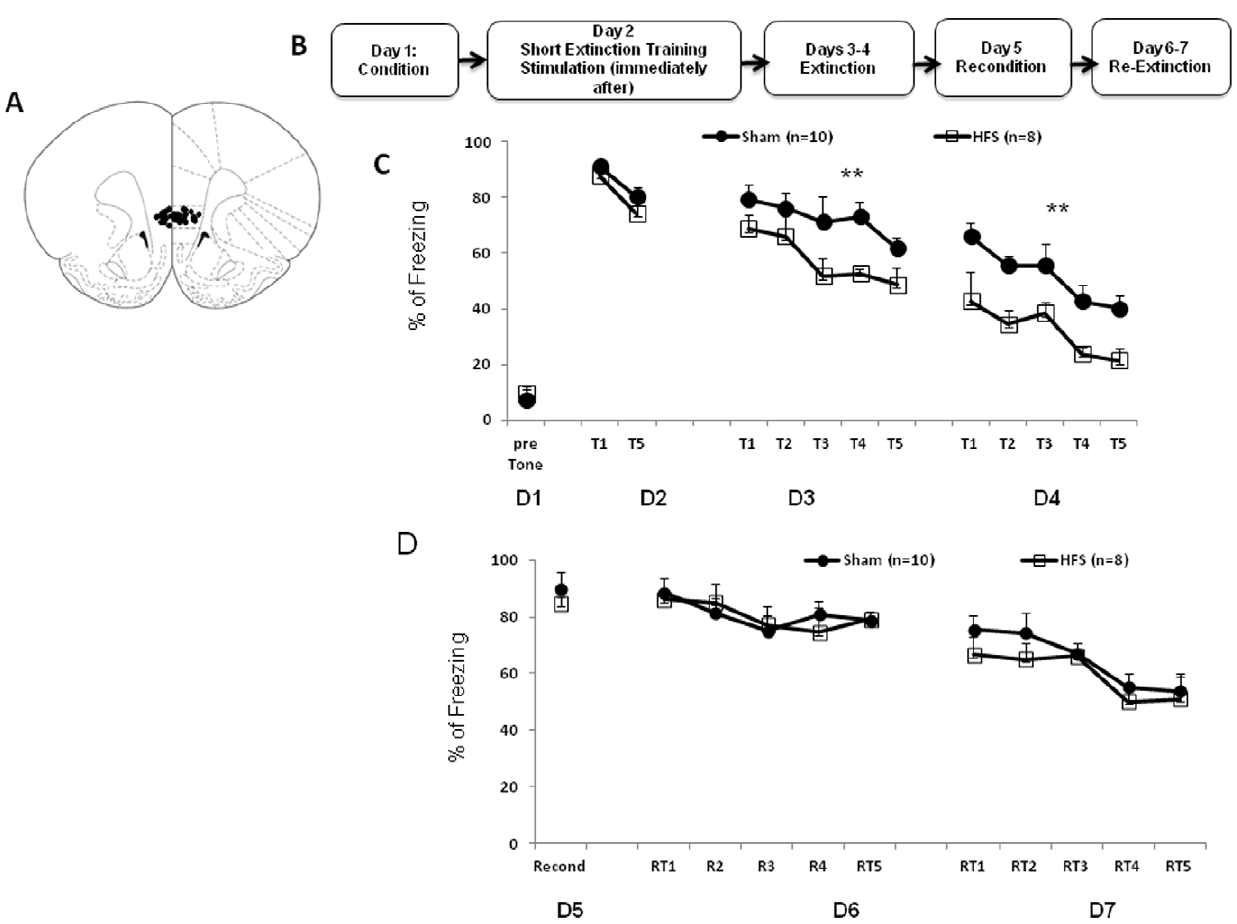
Figure 1. IL-HFS applied immediately after fear retrieval/short extinction training reduces fear during extinction. ( A ) Schematic diagram showing electrode placement in IL for the fear conditioning experiments. Diagram adapted from Paxinos and Watson 1998. ( B ) Timeline of behavioral testing and stimulation. ( C ) Percent freezing (mean 6 SEM) to CS during conditioning, fear retrieval, and extinction in rats receiving either sham or HFS after fear retrieval. HFS rats showed reduced fear during extinction relative to Shams (** P , .01). ( D ) Percent freezing to CS during reconditioning and extinction in rats receiving either sham or HFS after fear retrieval. Reconditioning and re-extinction were not affected by prior IL stimulation. Data are Means 6